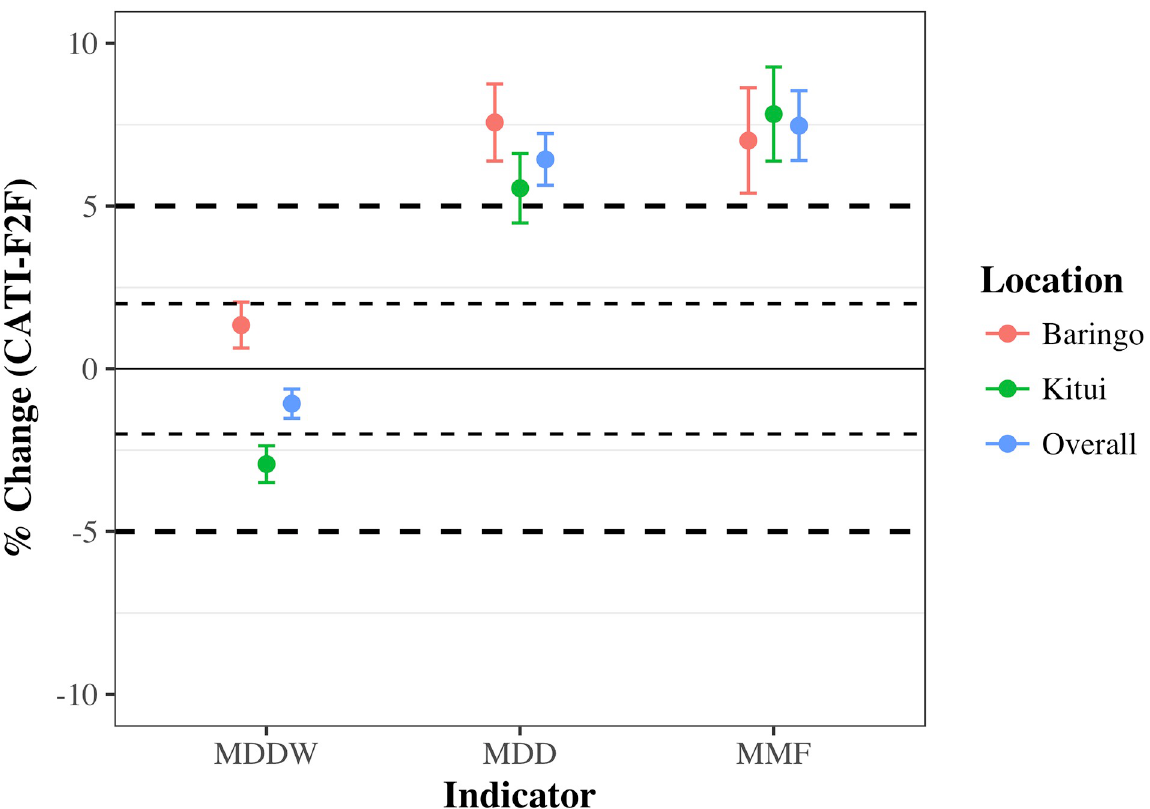
Fig 2. Equivalence of CATI and F2F scores for all nutrition indicators. While CATI and F2F give equivalent metric scores at the 2% for MDD-W, scores for MAD components MDD and MMF were only equivalent at the 9%